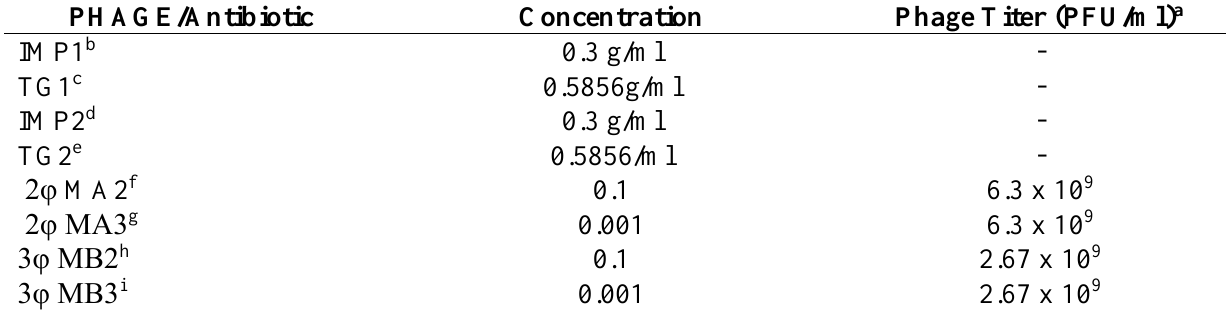
Supplementary Table 2 : The concentrations of the antibiotics and phage